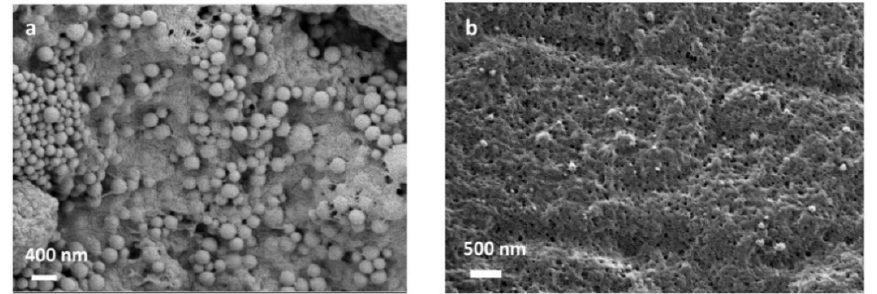
Figure 7 . Scanning Electron Microscopy (SEM) image of the chitosan/gelatin/SiGe NP- coating after immersion in PBS solution: ( a ) one day, and ( b ) 21 days. (Reprinted with permission from Ref [72]. Copyright 2020 Elsevier.)